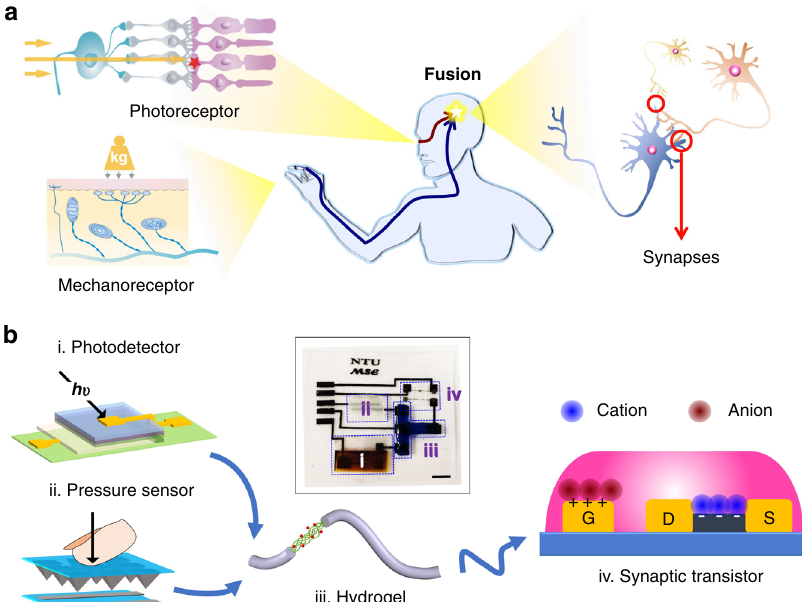
Fig. 1 A bimodal arti fi cial sensory neuron with visual-haptic fusion. a The visual-haptic fusion by biological neural network. b The BASE patch for visual- haptic fusion. Sub- fi gures i to iv: photodetector, pressure sensor, hydrogel (dyed by 0.04% methylene blue), and synaptic transistor, respectively. Inset: a photograph of the BASE patch. The scale bar is 5